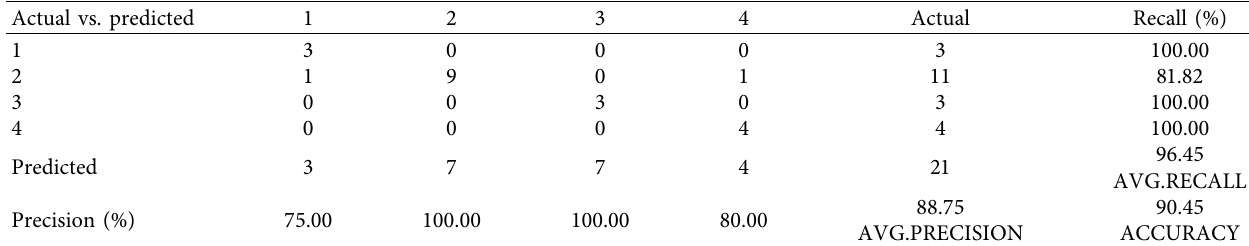
Table 10: Confusion matrix of fusion model test results and model evaluation related indicators. Actual vs. predicted